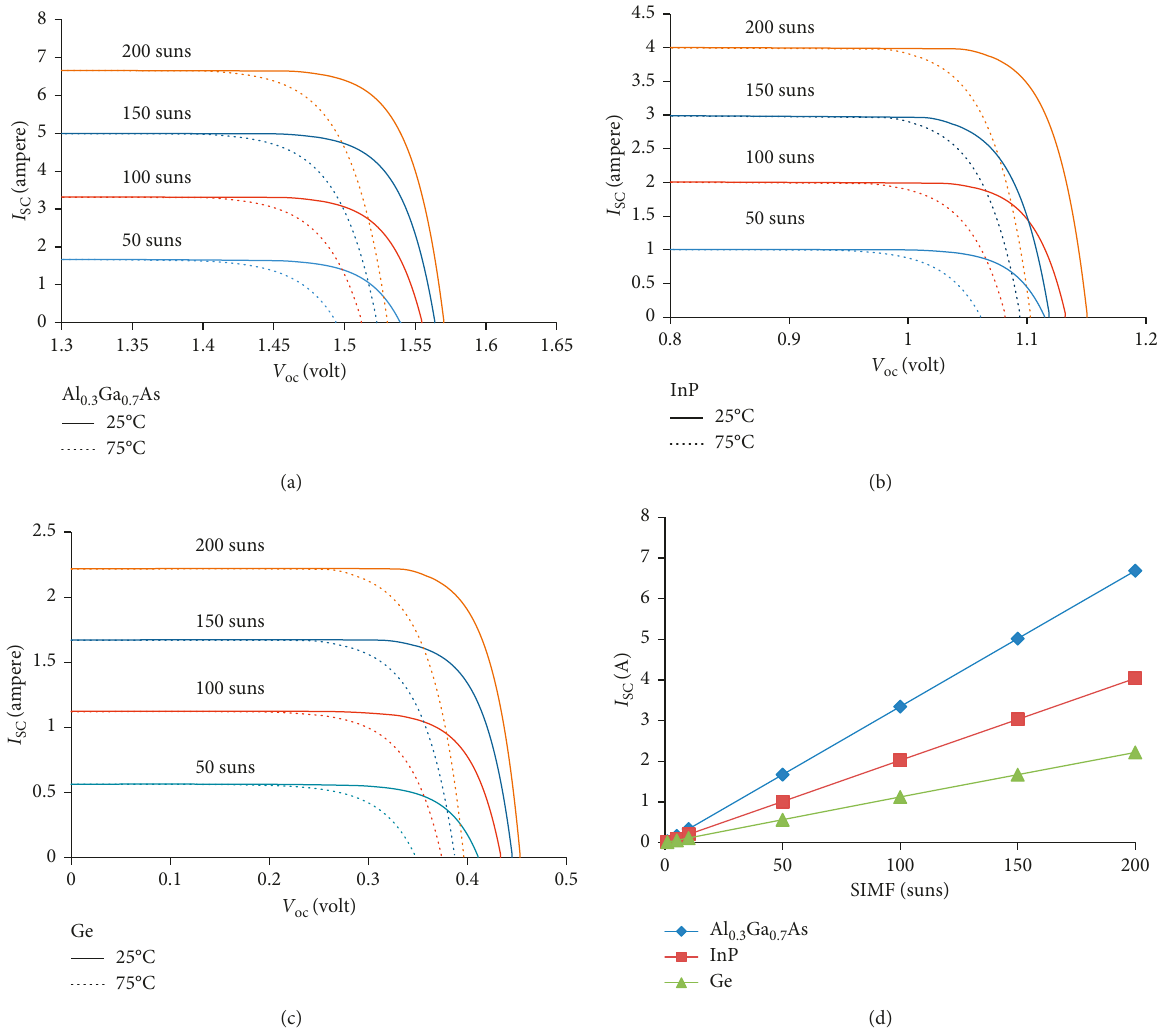
Figure 5: The comparison of I-V profile at 25 ° C (solid line) and 75 ° C (dotted line) and various SIMFs for (a) Al and (d) the short circuit current, I SC , at various